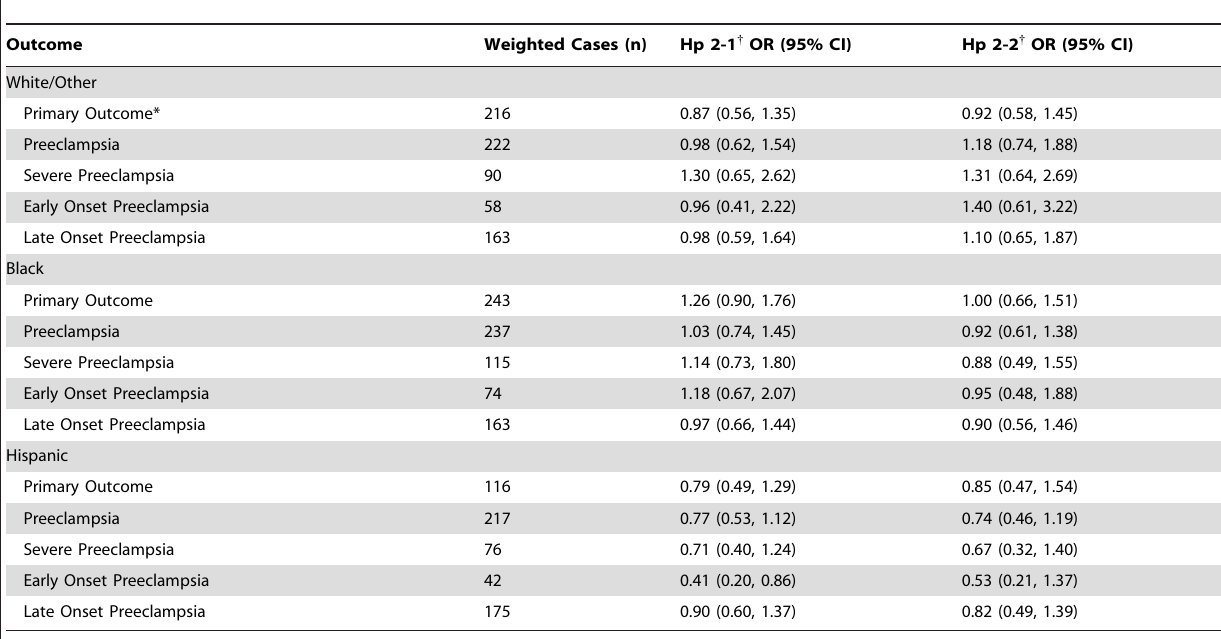
Table 2. Outcomes according to race/ethnicity and Hp phenotype in the weighted pooled